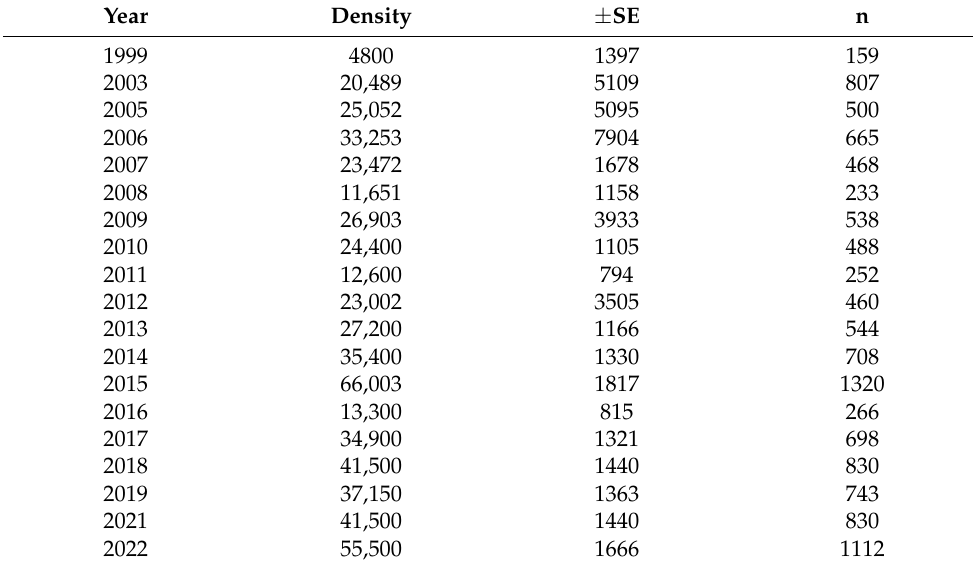
Table A1. Annual variation of dead horse arum densities (density: individuals/hectare ± SE; n: number of recorded plants during the four line transects) estimated from the four 25 m line transects in the high-density area (see more details in the text).